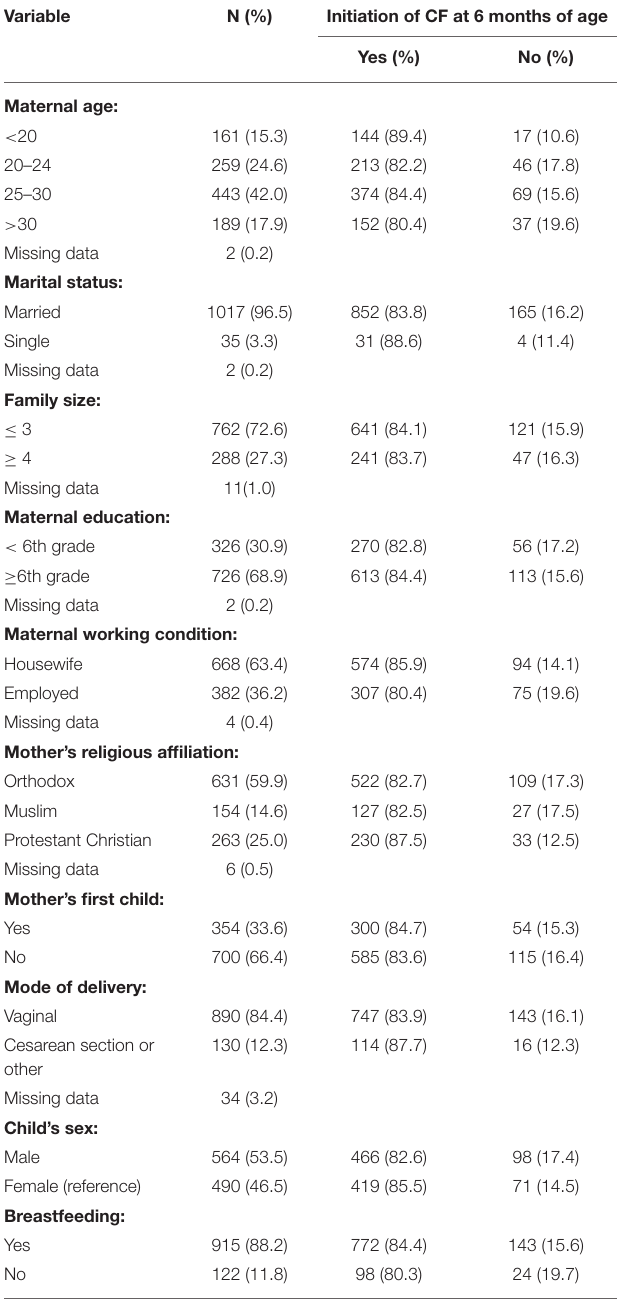
TABLE 1 | Proportion of initiation of complementary feeding (CF) at 6 months of age by maternal sociodemographic characteristics. Variable